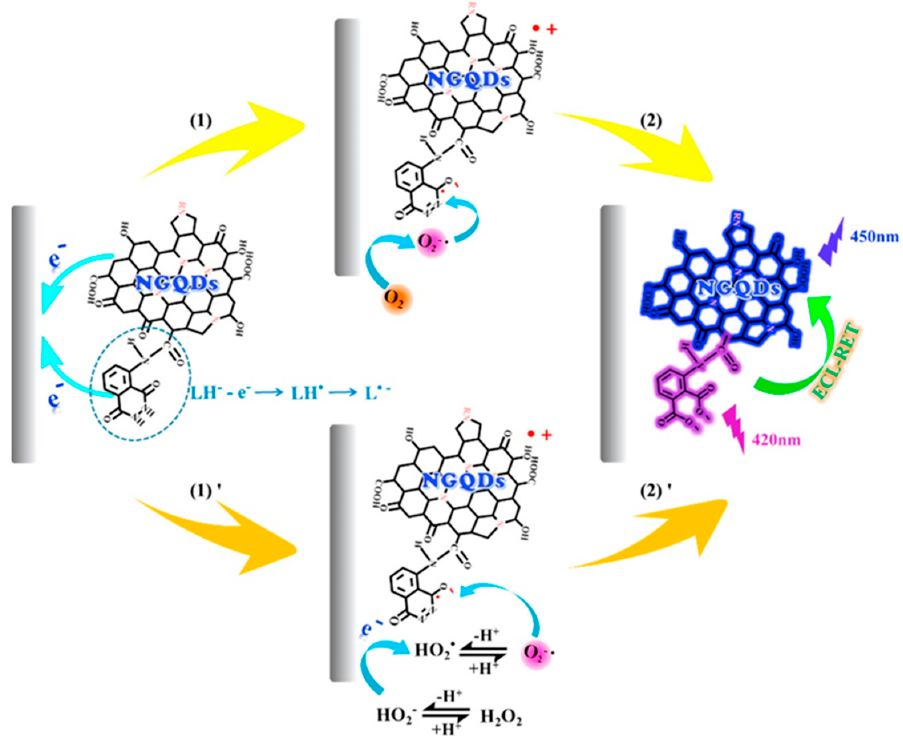
Figure 6. ECL ‐ RET mechanism of luminol ‐ NGQDs in H 2 O 2 detection in water samples. Adapted Figure 6. ECL-RET mechanism of luminol-NGQDs in H 2 O 2 detection in water samples. Adapted with the permission of Ref. [119]. with the permission of Ref.